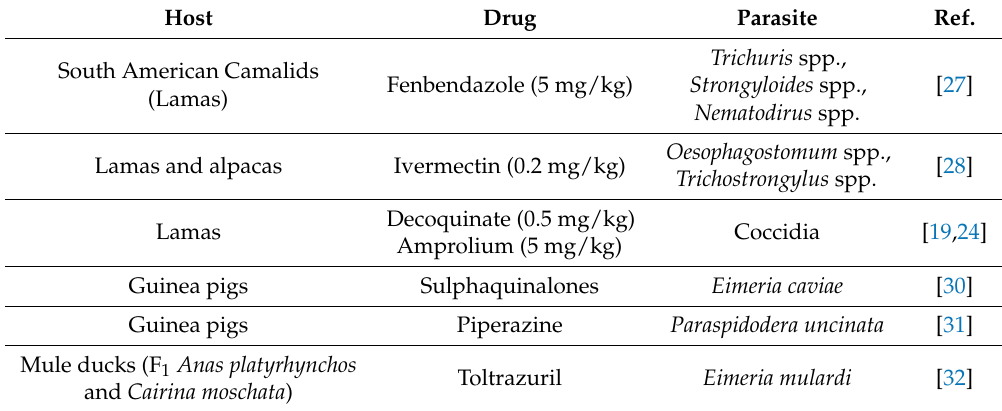
Table 2. Drugs used in the Treatment of endoparasites in Non-Domesticated Neo-Tropical